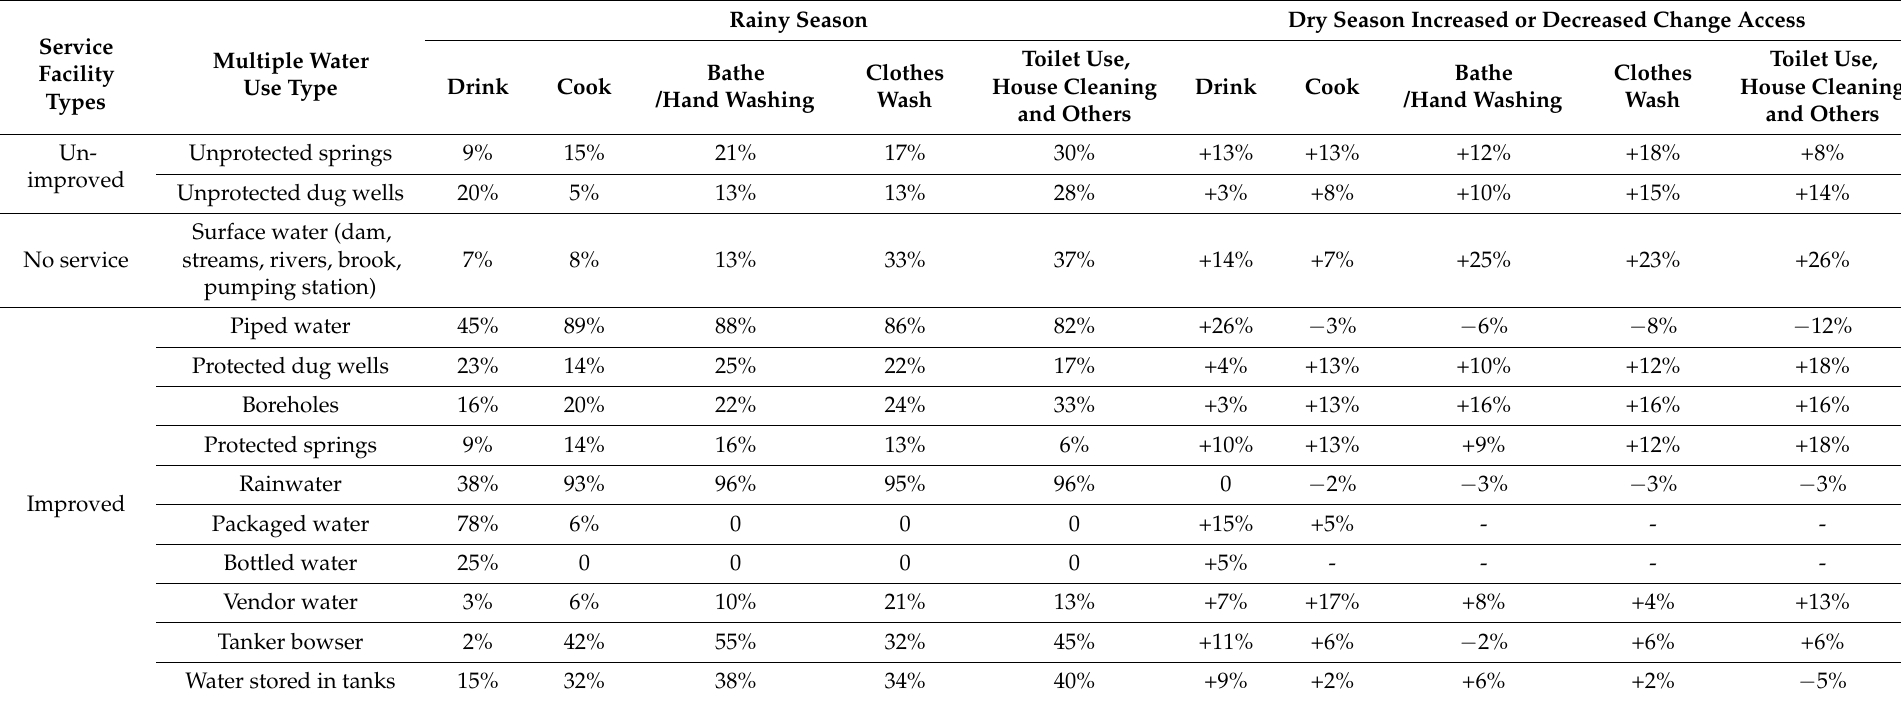
Table 1. Household percentage use of multiple water sources in the rainy and dry season for different water